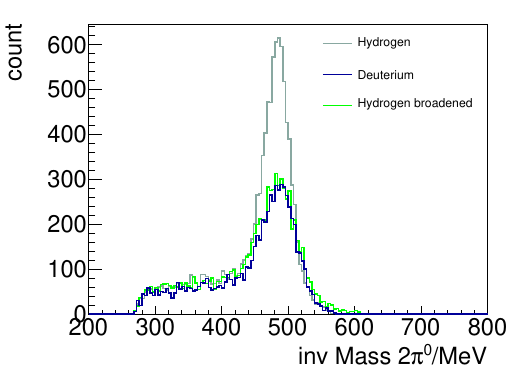
Figure 5. 2 π 0 invariant mass spectrum for simulated γ p → K 0 Σ + on hydrogen and deuterium target, as well as the hydrogen data set broadened according to the momentum distribution of nucle- ons in deuterium.